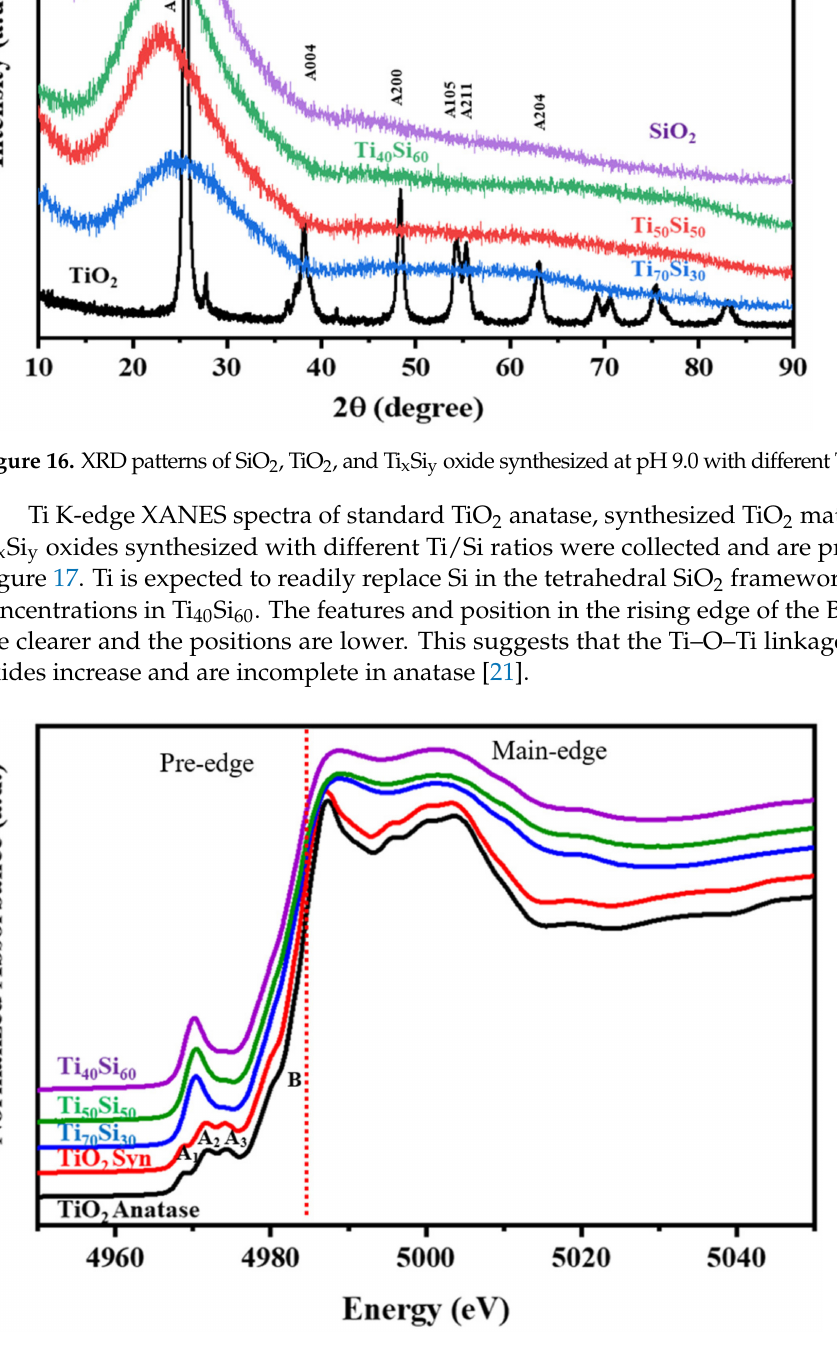
Figure 17. Ti K -edge XANES spectra of TiO 2 and Ti x Si y oxide synthesized at pH 9.0 with different Ti/Si